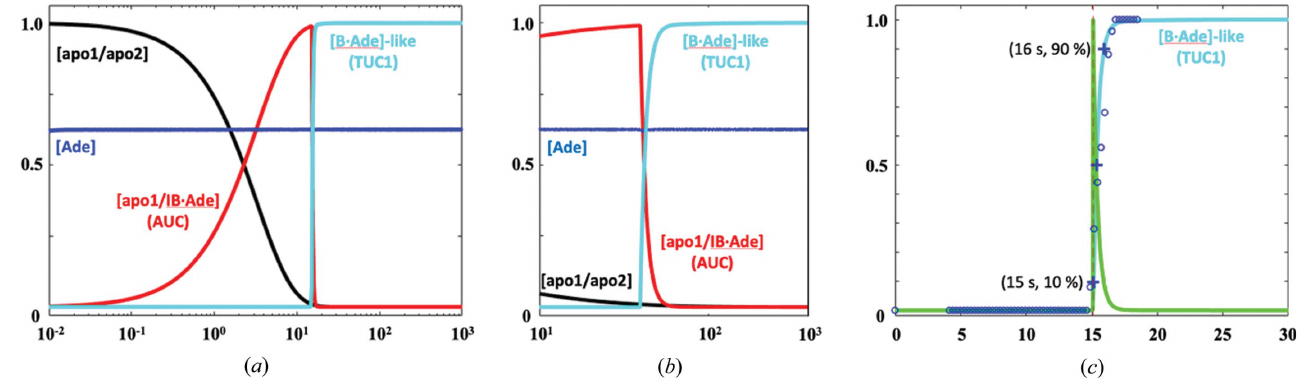
Figure 5 ( a ) Semi-quantitative kinetic profile of conformation species in the crystals based on the birefringence intensity measurements using a two-step model. ( b ) Expanded time range in ( a ) showing the coexistence of AUC (red) and TUC1 (cyan). ( c ) Experimentally measured conversion fraction of [B (cid:2) Ade]- like (blue circles) versus time superimposed with the time course of the first lattice transition (cyan). The first derivative (green) is also shown, which peaks at 15.2 s, the center of the T1 transition. The time points of [B (cid:2) Ade]-like at 10 and 90% are